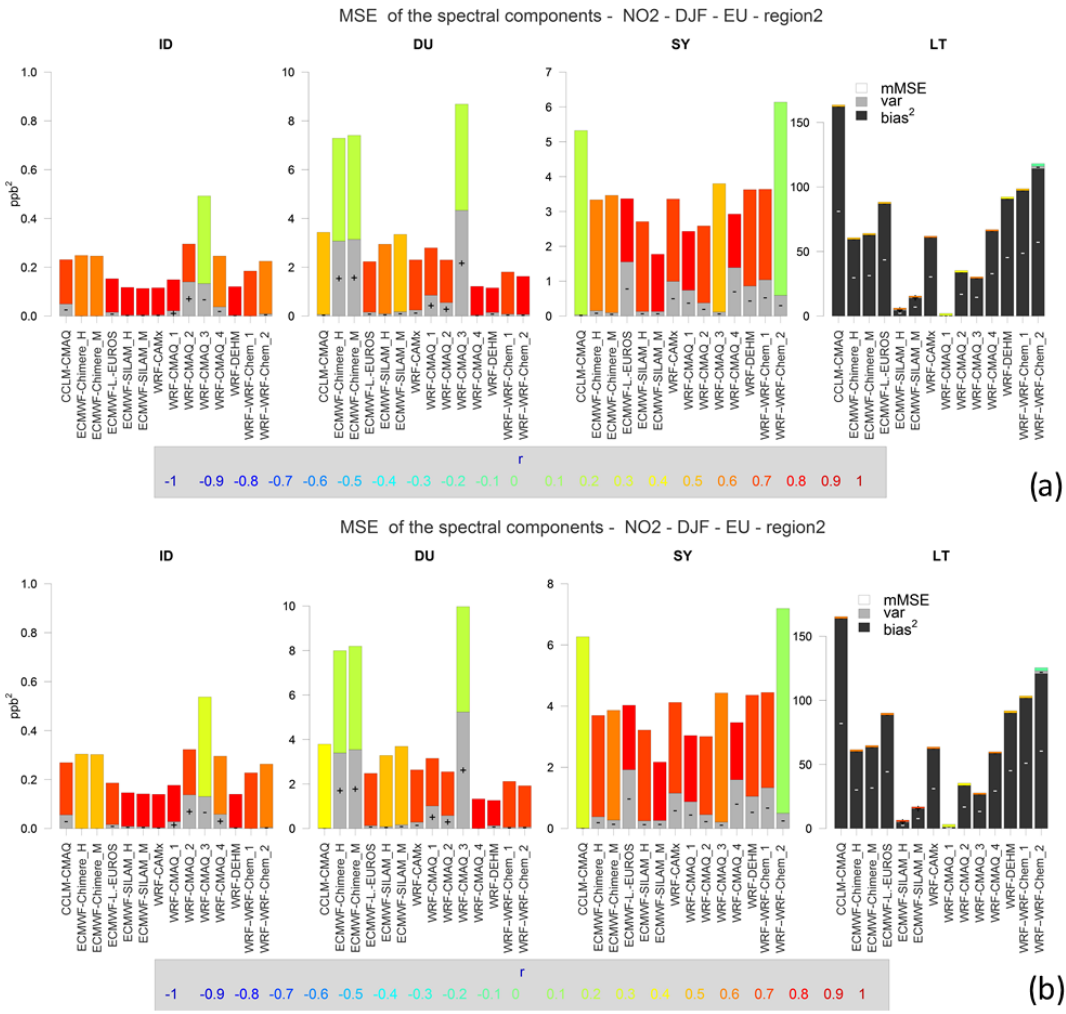
Figure 15. As in Fig. 10 but for NO 2 in EU2. Upper panel is urban sites only (223 stations); lower panel is rural sites only (159